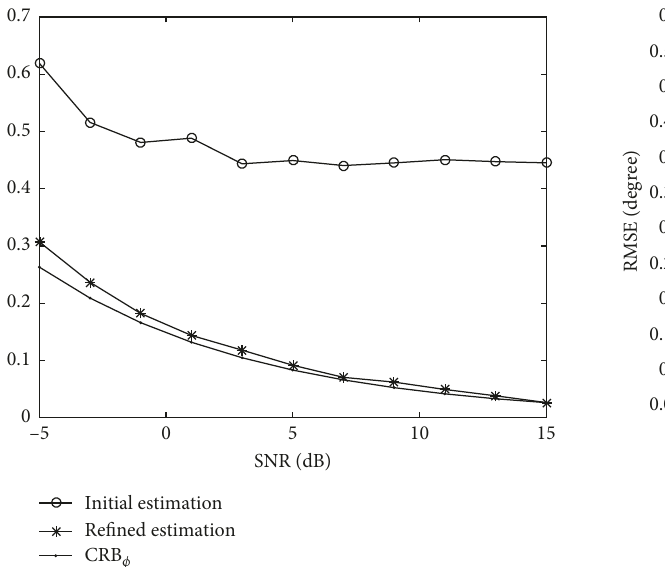
Figure 9: Angle estimation performances with different snapshots.